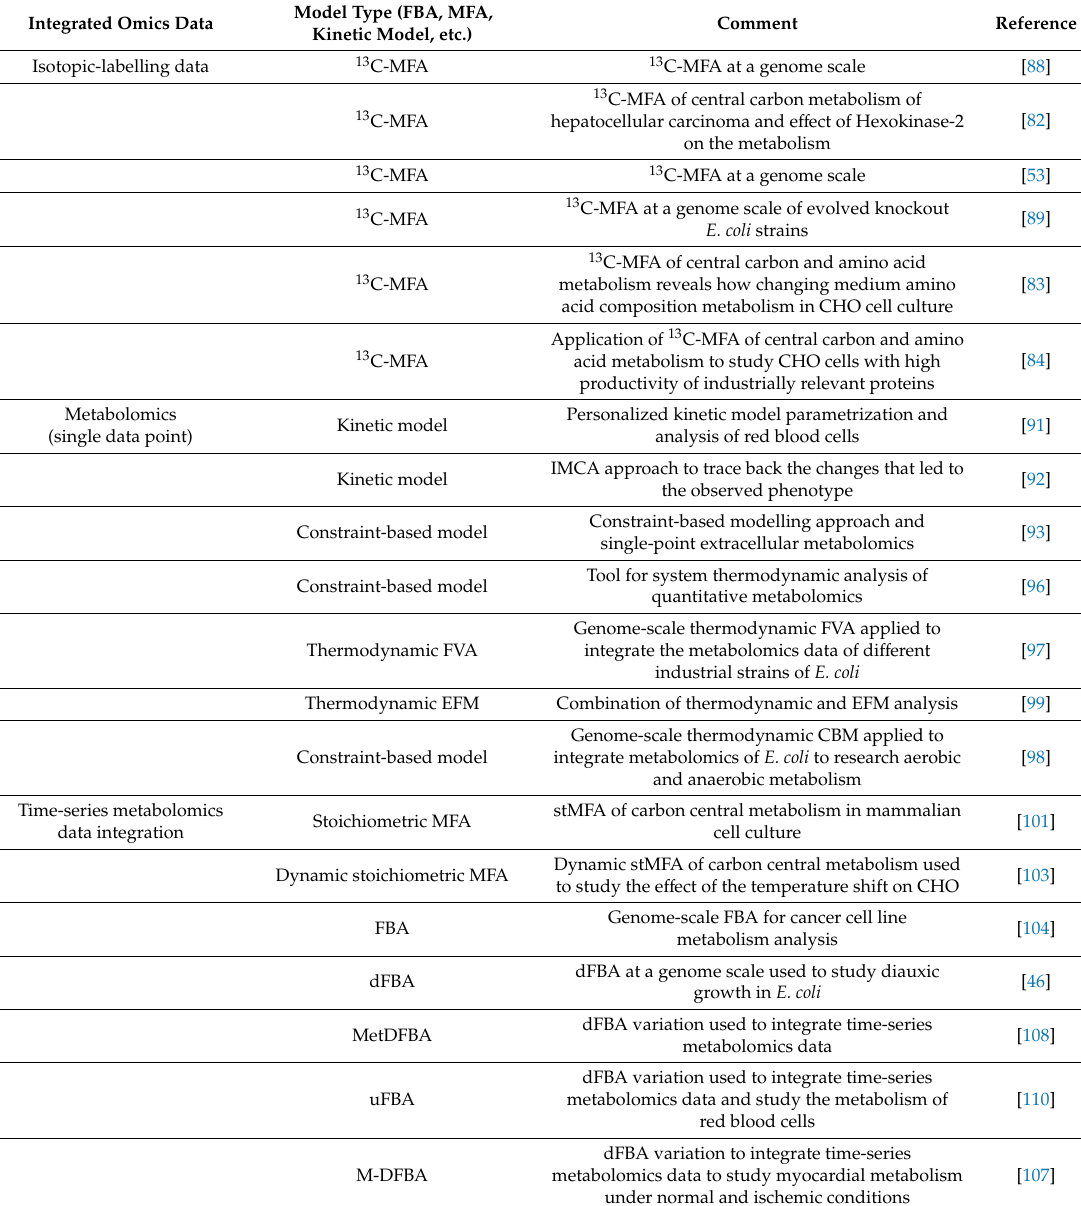
Model Type (FBA, MFA, Kinetic Model, etc.)